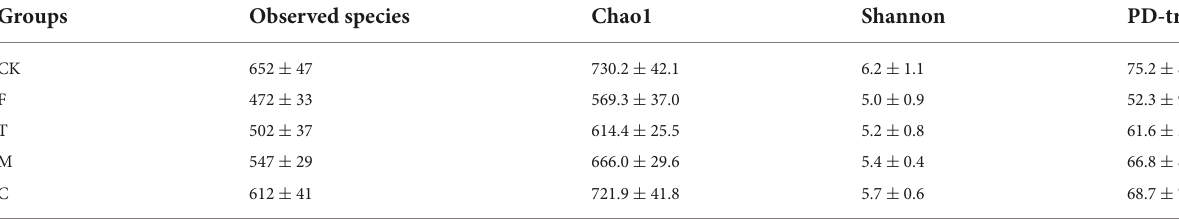
TABLE 4 Alpha diversity indexes of cecal microbiota associated with mice from CK, F, T, M, and C groups. Groups Observed species Chao1 Shannon